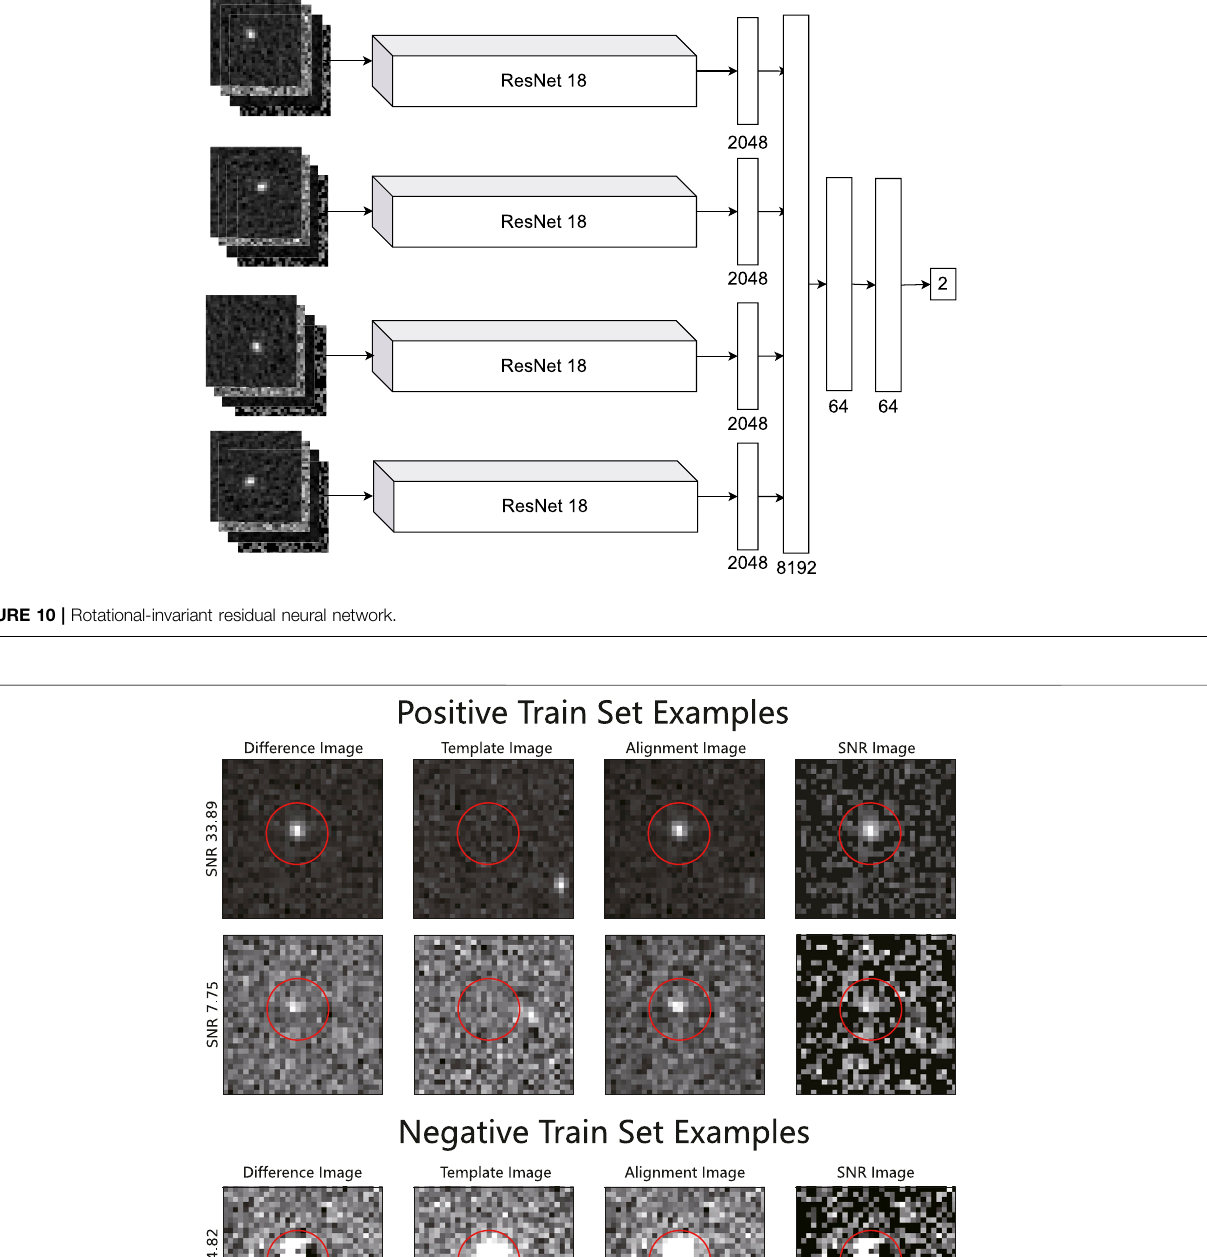
Frontiers in Astronomy and Space Sciences |